Question: Give a one-sentence summary of this figure.
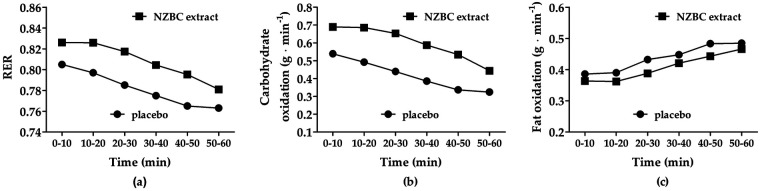
Answer: Respiratory exchange ratio (a) , carbohydrate oxidation (b) , and fat oxidation (c) for placebo and New Zealand blackcurrant extract during a 1-h moderate-intensity treadmill run at 50% V ˙ O 2 max .